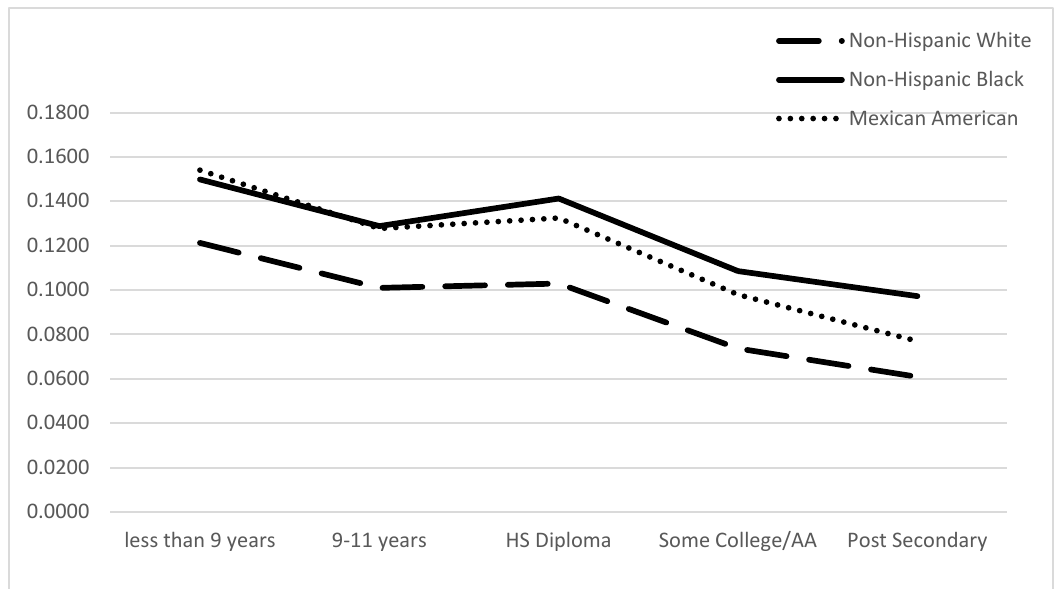
Figure 1. Predicted probability of intermediate c-reactive protein by education and race/ethnicity. Note: Differences across groups statistically significant at the p < 0.001 level. Model controls for age, diabetes, heavy drinker, HBP, HWC, income, sex, smoker, and statin